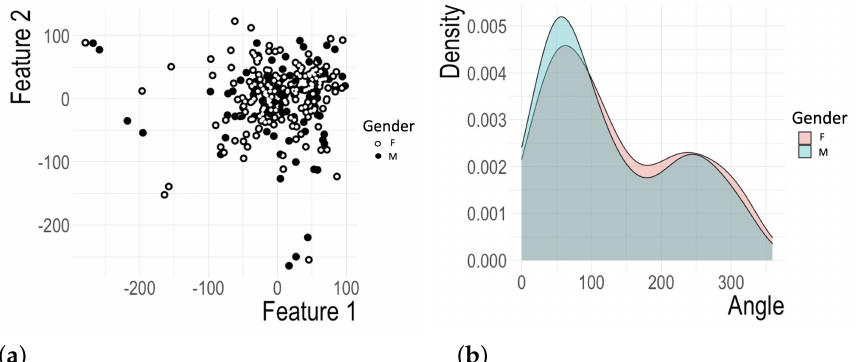
Figure 4. ( a ) A scatter plot representing male and female participants in the feature space of experimental data collected in Experiment 1. ( b ) The kernel density plots of the line-drawing angles in Experiment 1 for male and female subjects. The Mann–Whitney U-test of the distributions of line-drawing angles shows that there is no statistically significant sex-specific difference in line angel preferences between men and